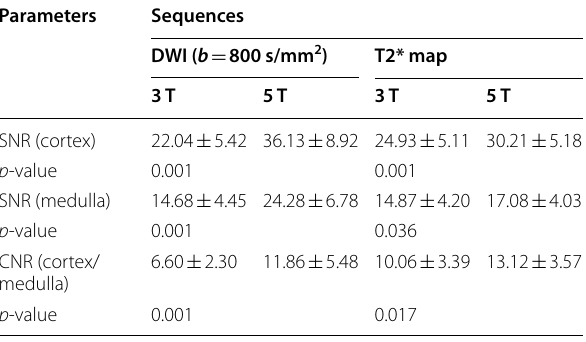
SNRs and CNRs are given as mean DWI diffusion-weighted imaging; SNR signal-to-noise ratio; CNR contrast-to- noise ratio